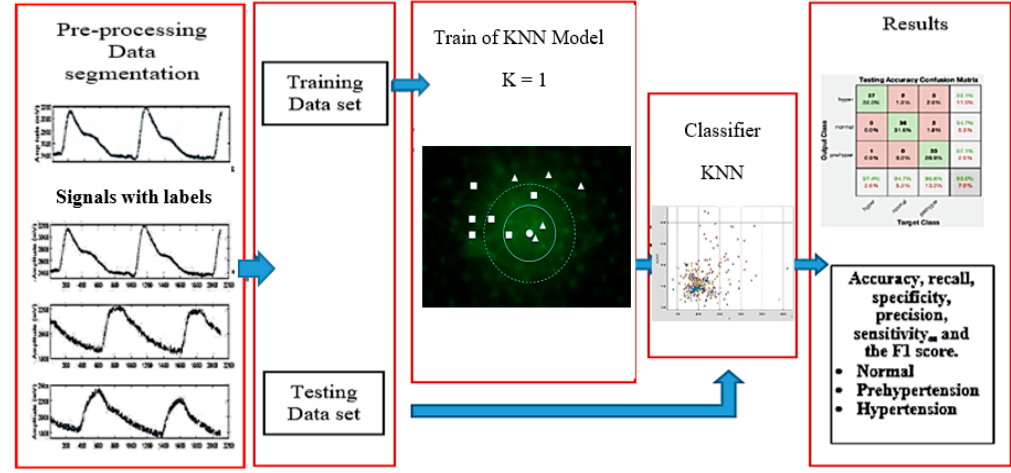
Figure 7 . Detailed block diagram of the proposed BP classi fi cation technique. Figure 7. Detailed block diagram of the proposed BP classification